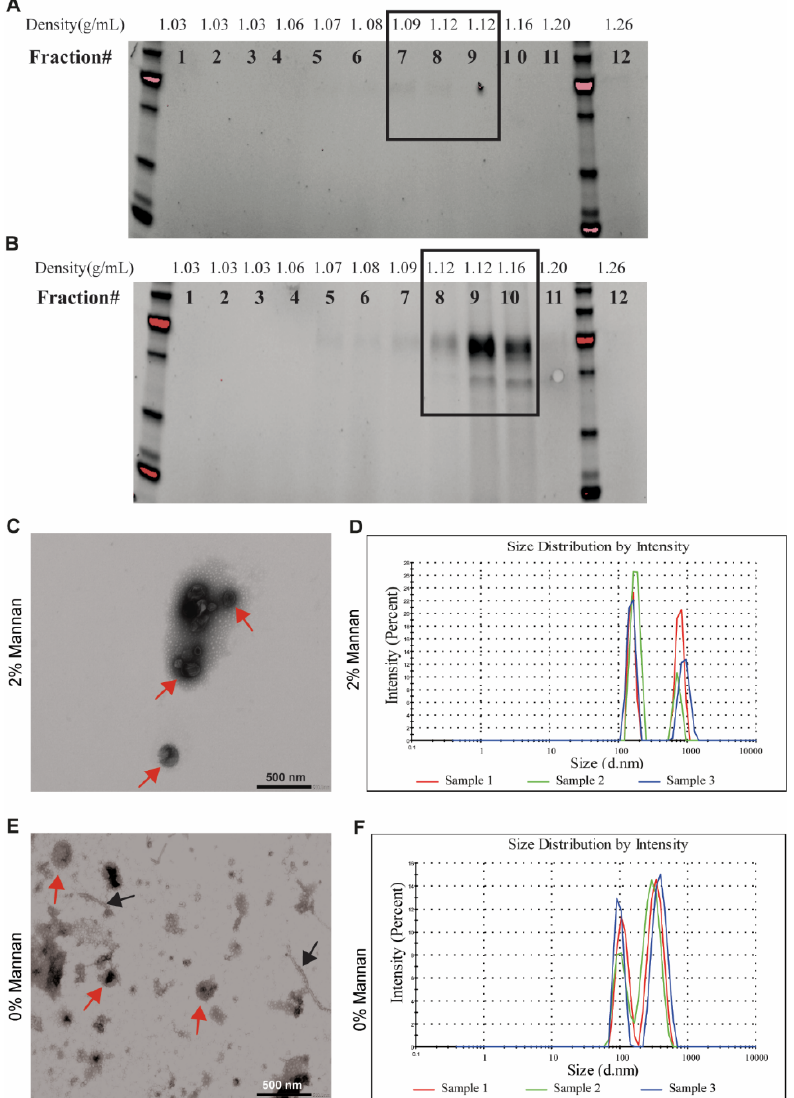
Figure 2. Characterization of secreted EVs from a pig fecal inoculum. The fecal inoculum was cultivated in vitro either in the presence of 2% β-mannan or without any carbohydrate source for 24 h before removing the cells from the culture medium. Density of EVs isolated from fecal culture on basal medium ( A ) or supplemented with 2% β-mannan ( B ) using a density gradient. Twelve fractions were recollected from the top of the gradient and analyzed using SDS-PAGE. The electron microphotograph shows that the sample recovered after ultracentrifugation and density gradient separation was bacteria-free and consisted of vesicles shaped as spheres in the presence of 2% β-mannan ( C ) or without carbohydrate ( E ). The red arrow indicates EVs, while black arrows indicate “pili-like” structures. The scale bar indicates 500 nm. Size of the vesicles isolated in the presence of 2% β-mannan ( D ) or without carbohydrate ( F ) was visualized by a Zetasizer uV.